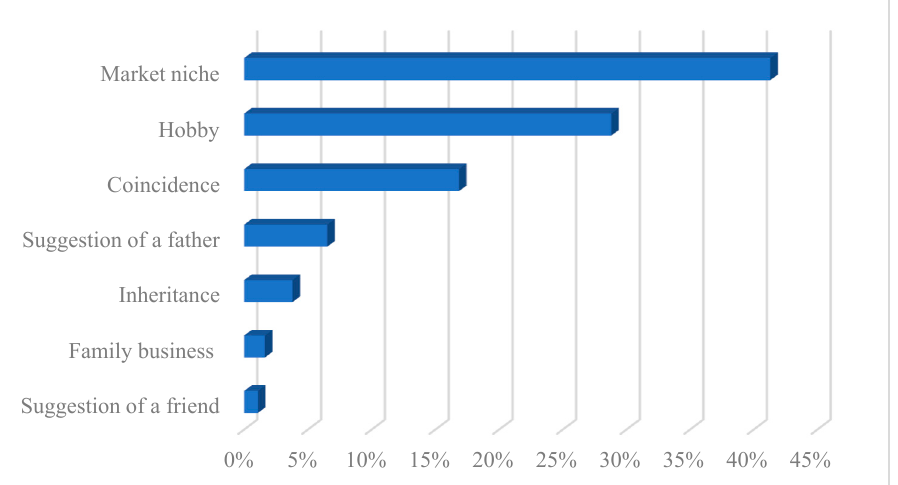
Figure 2. The source of the idea for running a business (Appendix B).